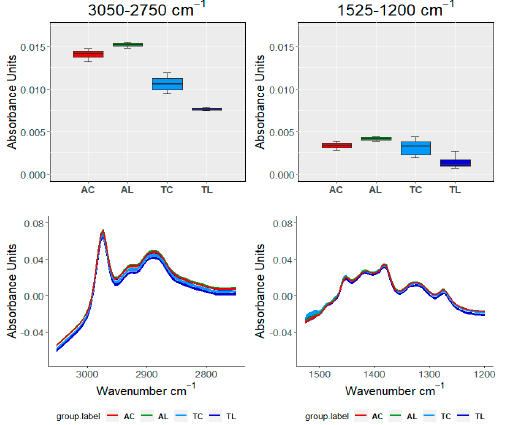
Figure 5. Plots of two of the four significant areas of the curves with an ageing time of 6 months. In